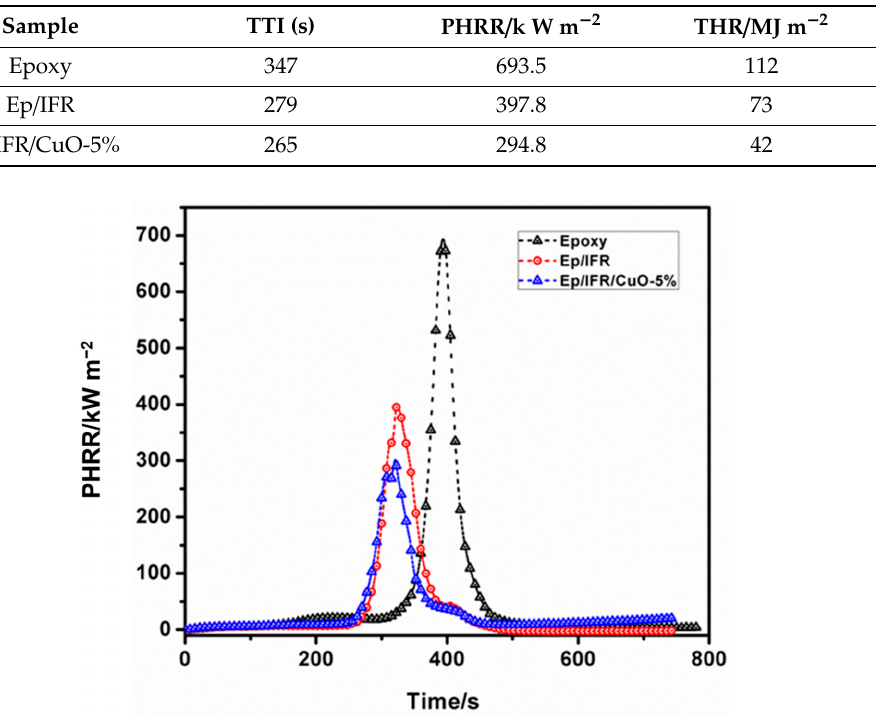
Figure 4. Peak heat release rate curves of epoxy, Ep/IFR, and Ep/IFR/CuO-5% samples.